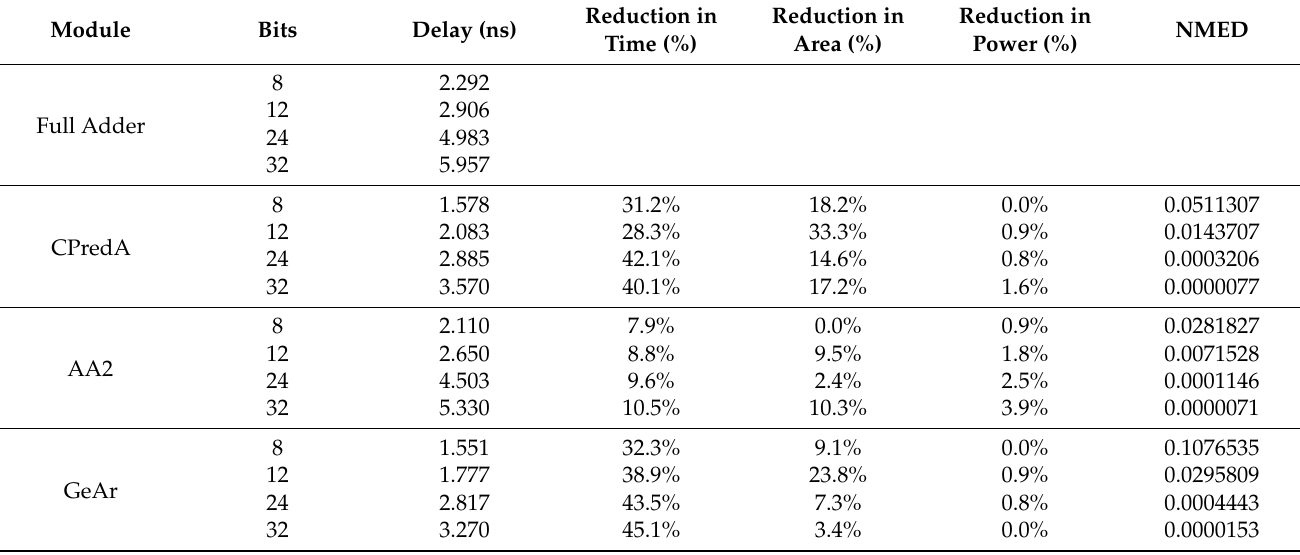
Table 4. Adders testing results in half prediction